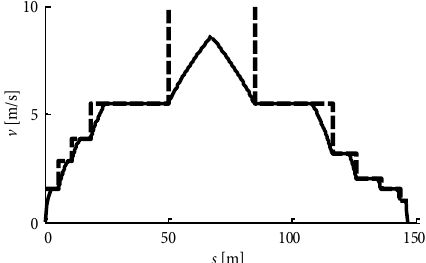
Fig. 16. Chart of the strenuous drive speed limit in the func- tion of the road (charts were determined: the dotted line – the speed limit due to limits on the permissible values of centripe- tal acceleration; solid line – linear and centripetal acceleration)